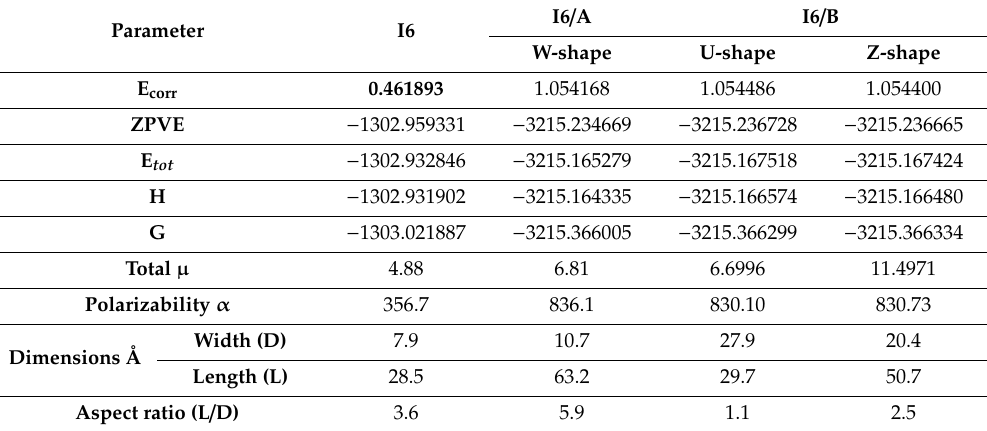
Table 2. Thermal parameters (Hartree / Particle) of the I6 base, as well as the I6 / A and I6 / B H-bonded complex